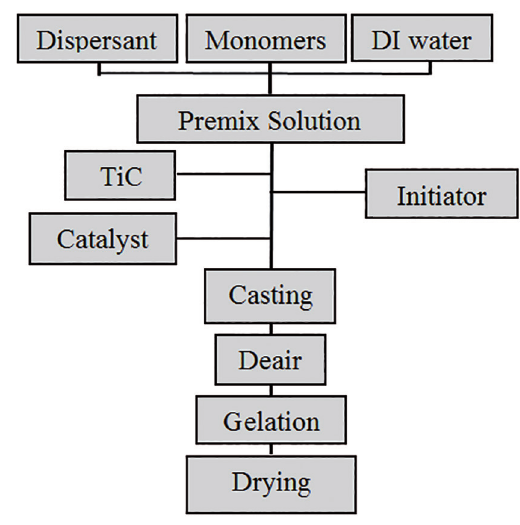
Figure 2: Flow chart of gelcasting